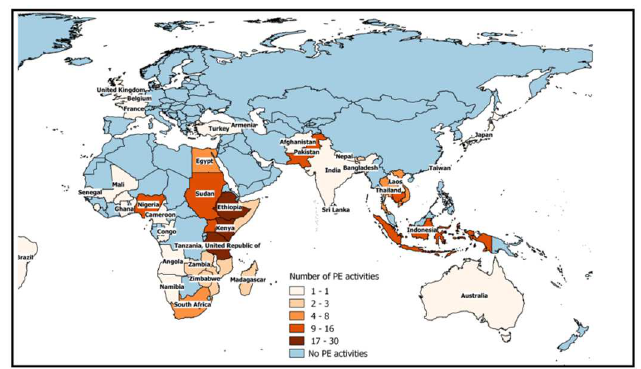
Fig 4. Number of participatory epidemiology activities in Europe, Africa, Asia and